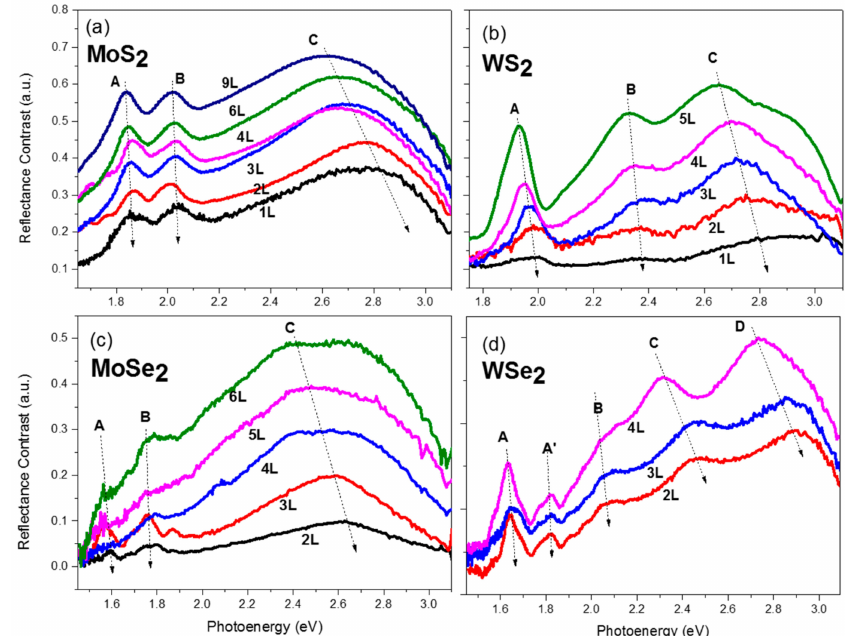
Figure 4. Reflectance contrast spectra of few-layer ( a ) MoS 2 , ( b ) WS 2 , ( c ) MoSe 2 , and ( d ) WSe 2 crystals. The excitonic features are marked in the figures according to conventional notations. The thickness is labeled in the figures as monolayer (1L), bi-layer (2L), tri-layer (3L), and so on. The spectra are vertically shifted for visual clarity. The dotted arrow lines are guides for the eyes.